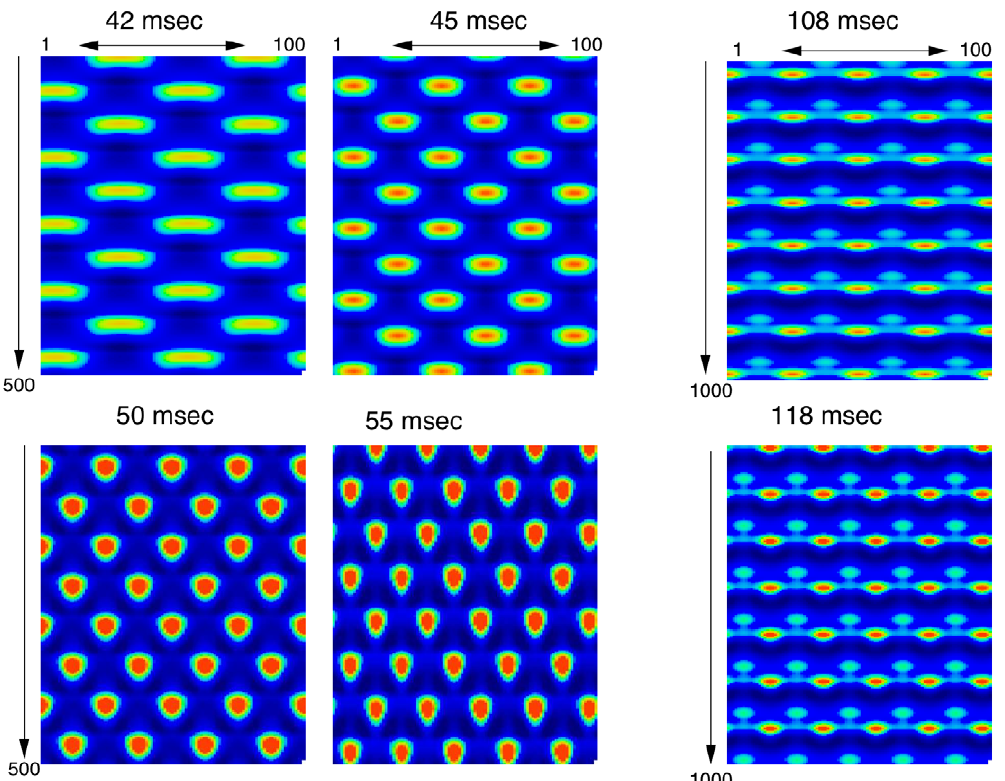
Figure 2. Space-time evolution of patterns produced by equations (1,2) in a one-dimensional spatial domain. s e ~ 2, s i ~ 5 , with periodic boundary conditions. Time increases in the vertical direction. Amplitude of the stimulus was 0 : 8 and the period of the stimulus is shown above each panel.